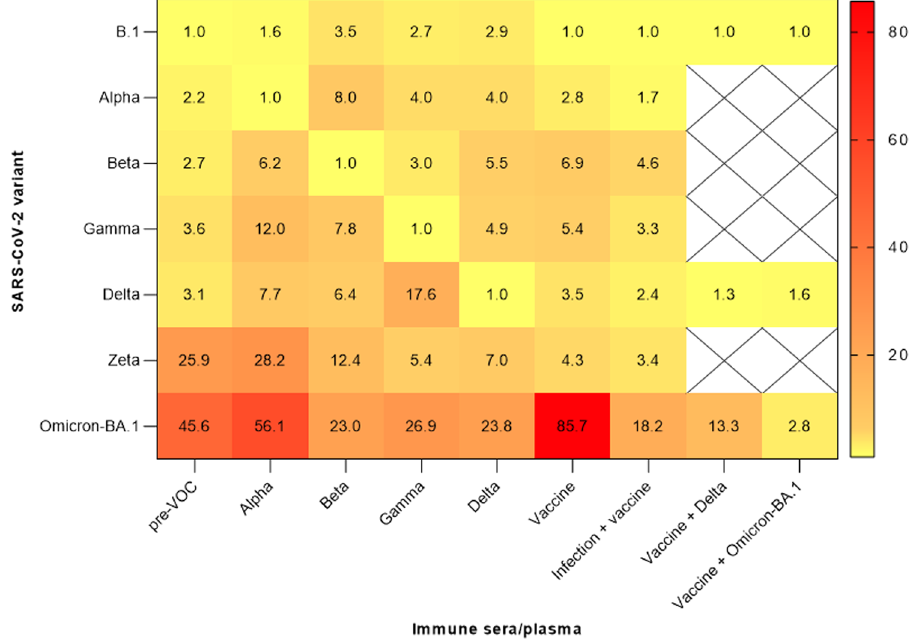
Fig. 2 Heatmap of fold-reduction in neutralization based on PRNT 90 data. Values of fold-reduction in neutralization (PRNT 90 ) of B.1, Alpha, Beta, Gamma, Delta, Zeta, and Omicron-BA.1 are presented as heat maps with darker colors implying greater changes. The immune sera/plasma were organized into cohorts of convalescent specimens that are derived from individuals infected with early-pandemic SARS-CoV-2 (pre-VOC) ( n = 34), Alpha ( n = 12), Beta ( n = 8), Gamma ( n = 10), Delta ( n = 10) and cohorts consist of individuals with double-dose mRNA vaccination ( n = 16), prior SARS-CoV-2 infection followed by double-dose mRNA vaccination ( n = 6), Delta breakthrough infection of double-vaccinated individuals ( n = 13) and, Omicron-BA.1 breakthrough infection following double ( n = 8) and single ( n = 3) mRNA vaccination. Source data are provided as a Source Data fi